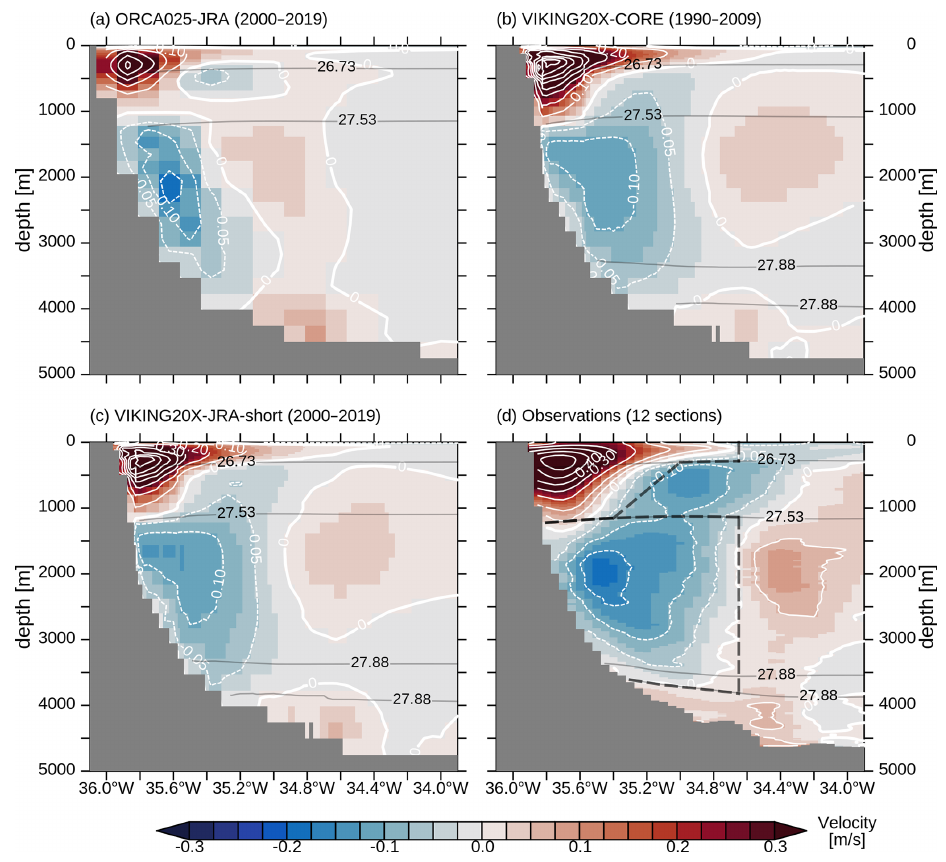
Figure 16. Mean along-shore velocity (ms − 1 ) section at 11 ◦ S for (a) ORCA025-JRA, (b) VIKING20X-CORE, (c) VIKING20XJRA-short and from (d) 12 observational ship sections in the periods 2000–2004 and 2013–2019 with σ 0 isolines. Dashed boxes in (d) indicate the area taken into account for NBUC and DWBC transport calculations.